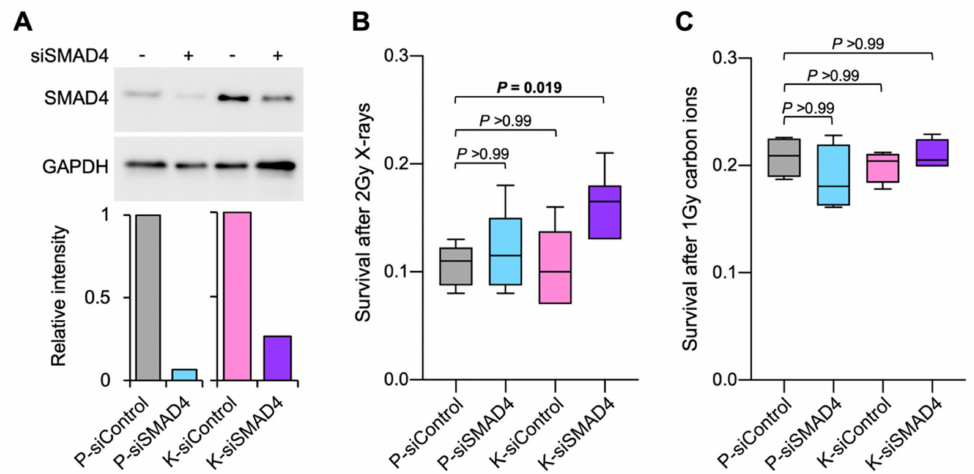
Figure 3. In vitro association of KRAS and SMAD4 mutations with cancer cell sensitivity to X-rays or carbon ions. ( A ) Immunoblots showing SMAD4 suppression by siRNA treatment. Band intensities were quantified using ImageJ v1.48, and data shown are normalized to those for GAPDH, a loading control. ( B ) Clonogenic survival after 2 Gy X-rays ( n = 6). ( C ) Clonogenic survival after 1 Gy carbon ions ( n = 4). Surviving fractions shown are after normalization to those of unirradiated controls for each setting. p values shown were calculated by Mann–Whitney U test followed by Bonferroni correction. P, parental SW48 cells; K, SW48 cells carrying a KRAS G12D